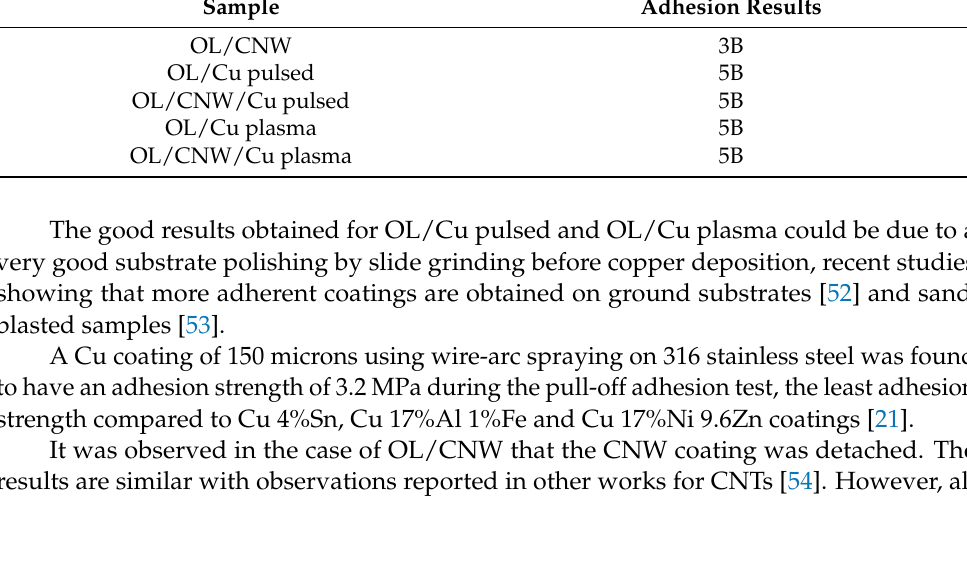
Table 1. Adhesion test results.